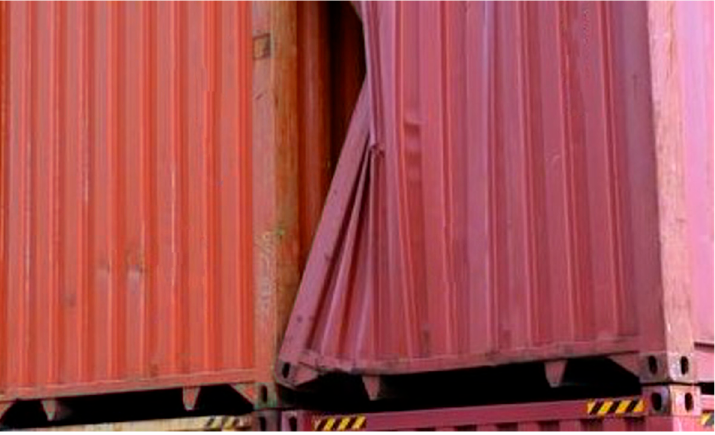
Figure 1. Example of a damaged marine container.